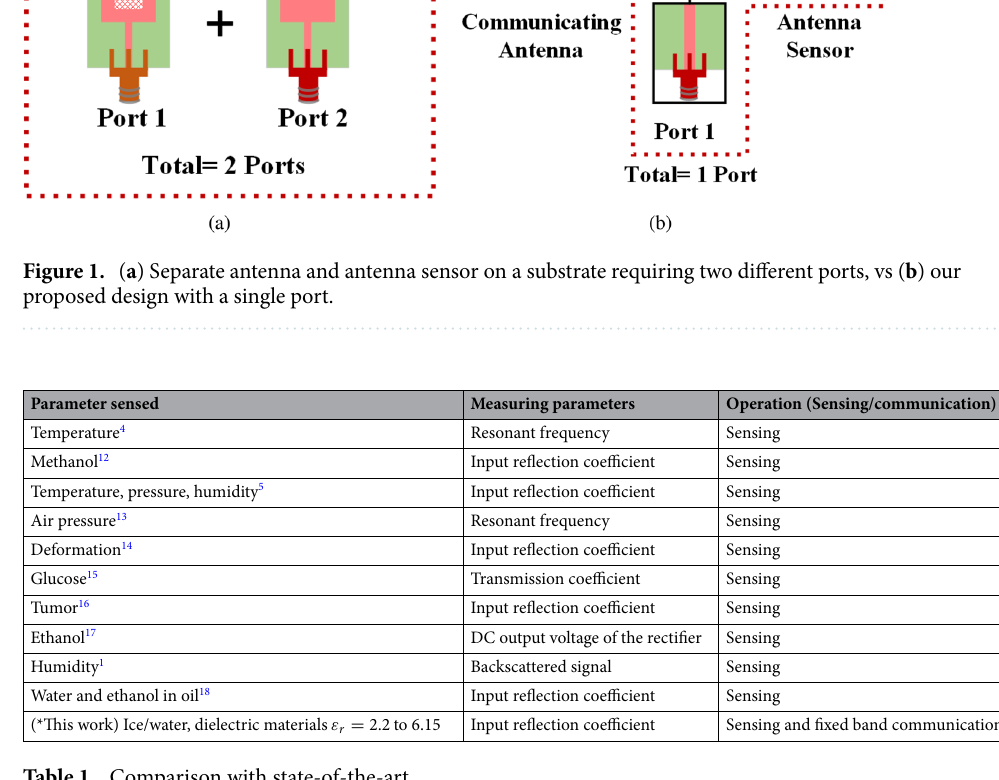
Table 1. Comparison with state-of-the-art.